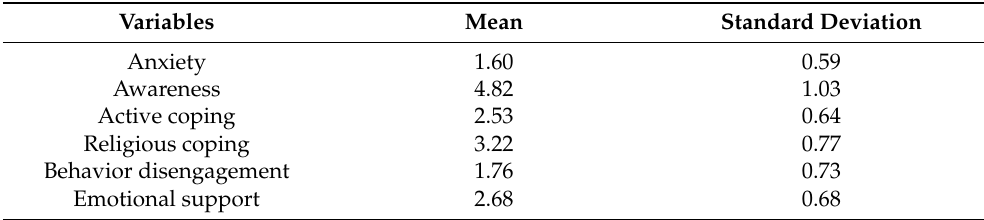
Table 1. Descriptive Statistics of the variables in this research.